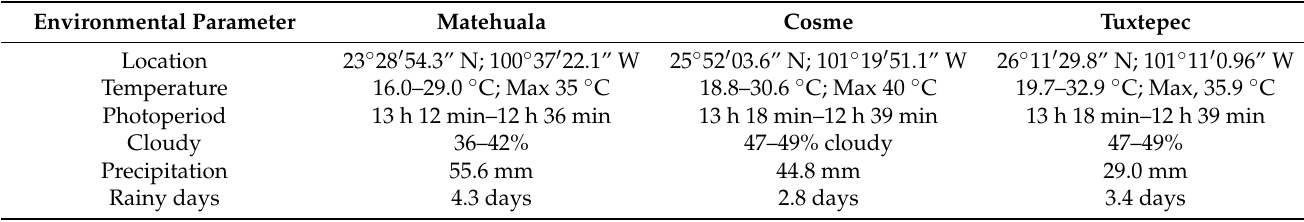
Table 4. Average geo-climatic conditions in August for the three sampled sites according to the CONAGUA climatic database (https://smn.conagua.gob.mx/) (accessed on accessed on 22 February